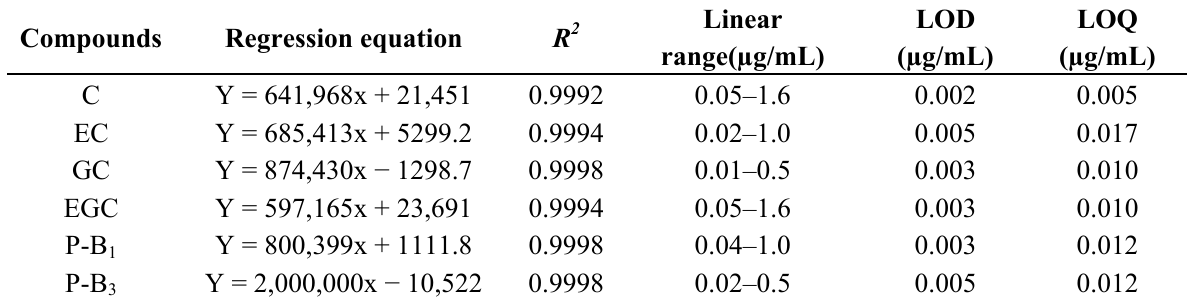
Table 2. Linearity and sensitivity properties of the